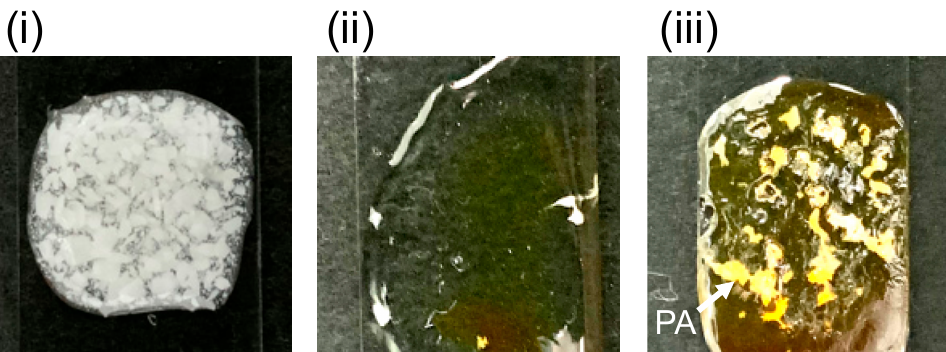
Figure 1. Photographs illustrating the curing of a (BADGE + PA + EM) {Bisphenol-A diglycidyl ether (BADGE), Phthalic anhydride (PA), 2-Ethyl-4-methylimidazole (EM)} adhesive before and after heating: ( i ) initial sample, ( ii ) curing the sample with microwaves for 10 min (microwave power, 500 W), and ( iii ) curing the sample in the electric furnace for 20 min.